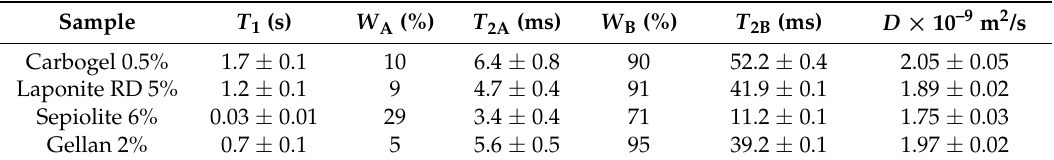
Table 1. T 1 and T 2 relaxation times and relative populations, and the self-diffusion coefficient measured in Carbogel 0.5%, Laponite RD 5%, Sepiolite 6%, and Gellan